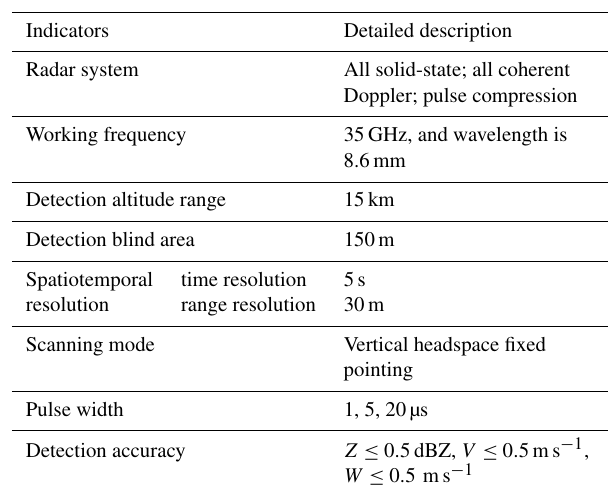
Table 2. Main parameters of